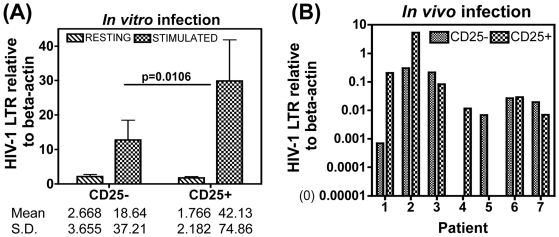
Increased susceptibility of Treg cells to in vitro HIV-1 infection.Purified CD4+CD45RO+CD25+ Treg cells and CD4+CD45RO+CD25− effector T cell populations from 12 healthy volunteers were infected with the HIV-1 X4 NL4-3 strain (MOI 0.1) and cultured either in IL-2 alone or stimulated with CD3/CD28 beads at 2∶ 1 bead: effector T cell ratio. 4 days later cells were harvested and HIV-1 LTR DNA levels determined by qPCR relative to the housekeeping gene beta-actin. (A) Relative copy number (RCN) of HIV-1 LTR copies in resting versus stimulated Treg and effector cells is shown in a paired analysis. (B) Paired analysis of RCN of HIV-1 LTR from stimulated Treg and effector cells isolated from 7 HIV+ subjects. For Fig 7(A), group comparisons by Kruskal-Wallis non-parametric test resulted in a 2-sided p-value <0.0001. Paired t-test was then used to compare CD25− v CD25+ samples; significant difference was noted between stimulated CD25− v stimulated CD25+ samples, p = 0.0106.